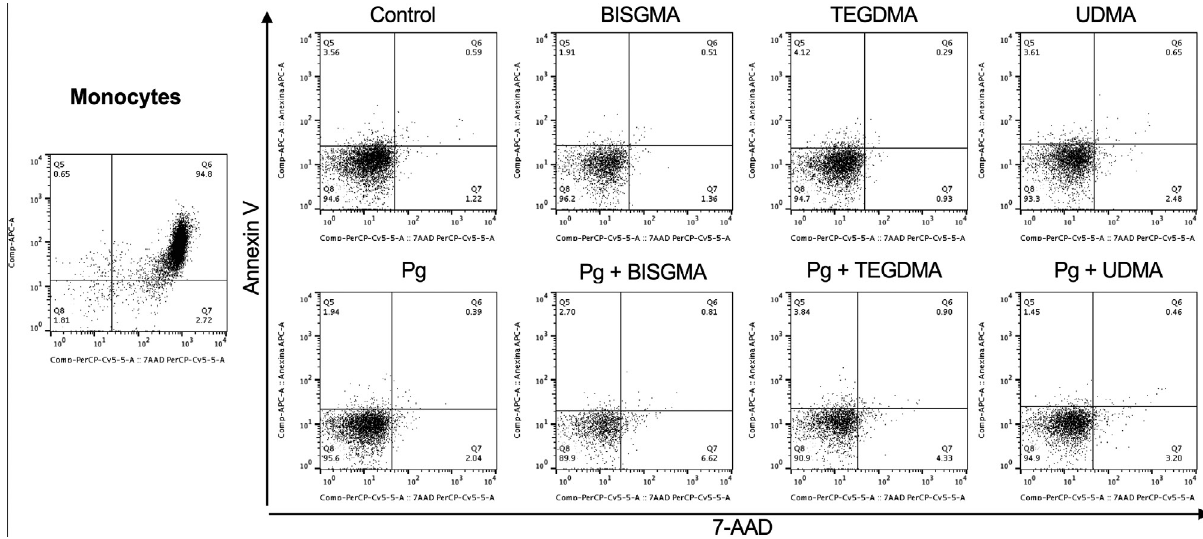
Figure 2- Dot plot graphs representative of Annexin V and 7AAD staining in the monocyte population after exposure to resin monomers and P. gingivalis . The dot plot on the left shows the monocyte population in the positive control (heat-killed peripheral blood mononuclear cells)